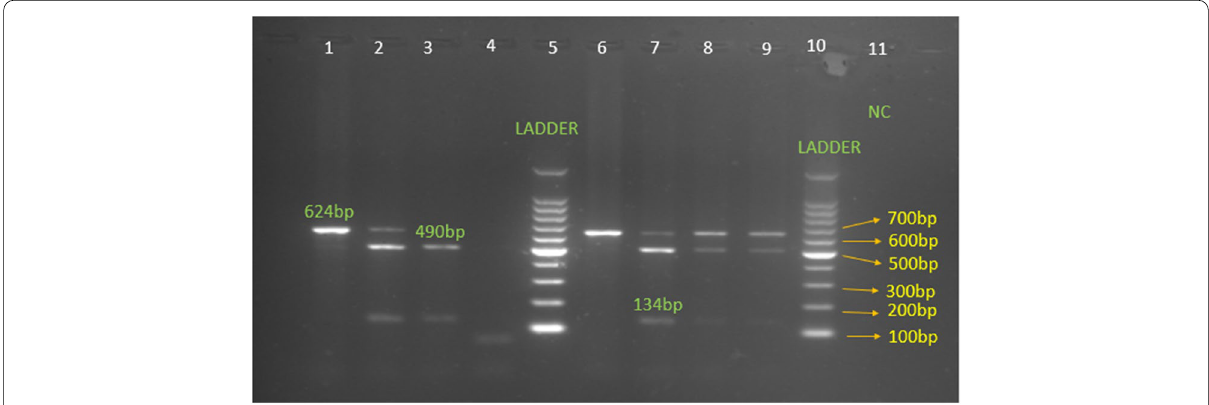
Fig. 1 PCR–RFLP analysis of rs12252 (42 T/C) polymorphism of IFITM3 gene by digestion with Mscl enzyme and separated by agarose gel electrophoresis. Lanes 1 and 6 show the CC genotype (624 bp), lane 3 shows the TT genotype (490 bp and 134 bp), and lanes 2 and 7 show the TC genotype (624 bp, 490 bp, 134